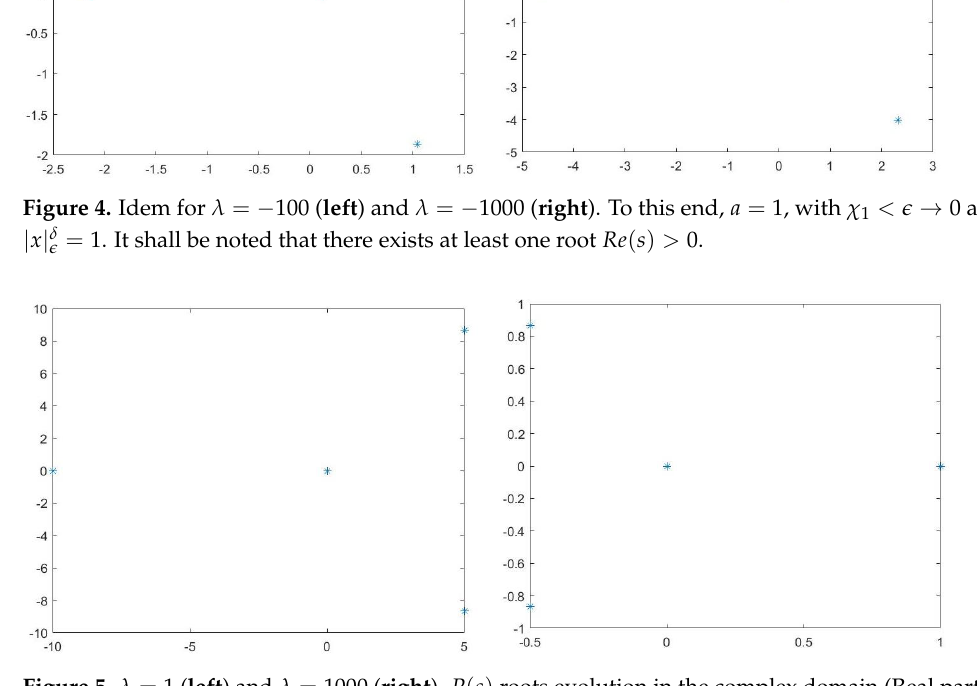
Figure 5. λ = 1 ( left ) and λ = 1000 ( right ). P ( s ) roots evolution in the complex domain (Real part in the horizontal and Imaginary in the vertical) for a = 1, with χ 1 → a and | x | δ (cid:101) = 1. It shall be noted that there exists at least one root Re ( s ) > 0.